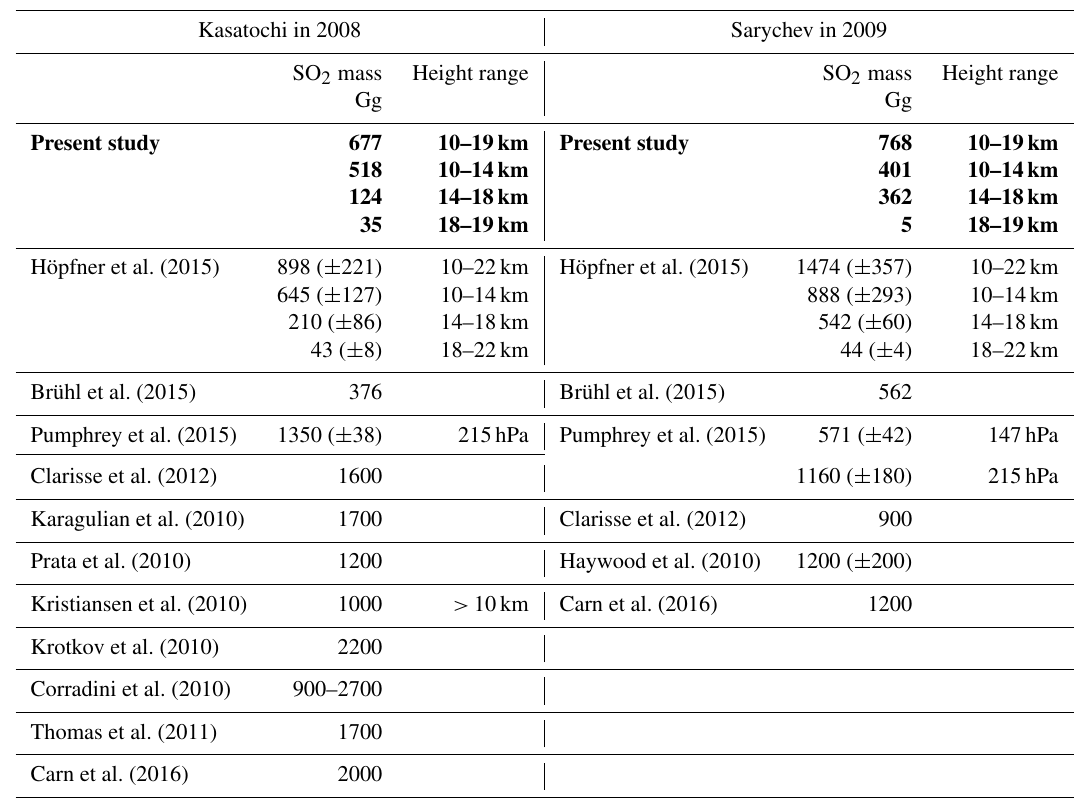
Table 1. Volcanically emitted SO 2 masses from various publications for Kasatochi in 2008 and Sarychev in 2009. For Höpfner et al. (2015) the given total uncertainty is the sum of the uncertainties per altitude range (their Table 3). In the case of Pumphrey et al. (2015) pressure levels are given. These represent the highest pressure used for vertical integration. The SO 2 masses used in the present modelling study are indicated in